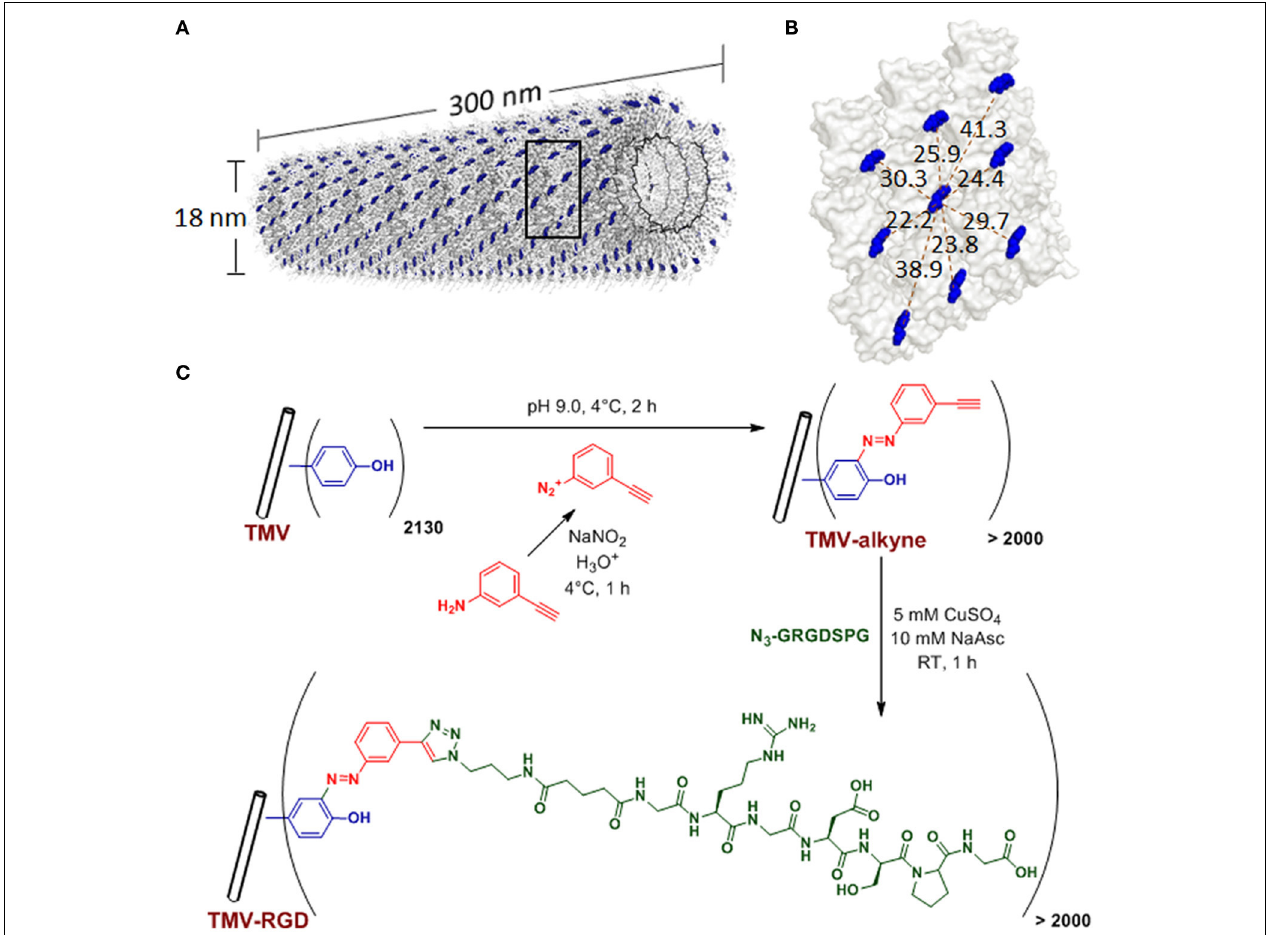
FIGURE 1 | TMV structure and bioconjugation scheme. (A) Computer reconstructed image showing TMV structure using PyMOL with coordinates from Protein Data Bank. The single stranded RNA inside TMV particle is represented by the black helix. The tyrosine 139 (Y139) residues of individual TMV coat proteins subunits are colored in blue while all other amino acid